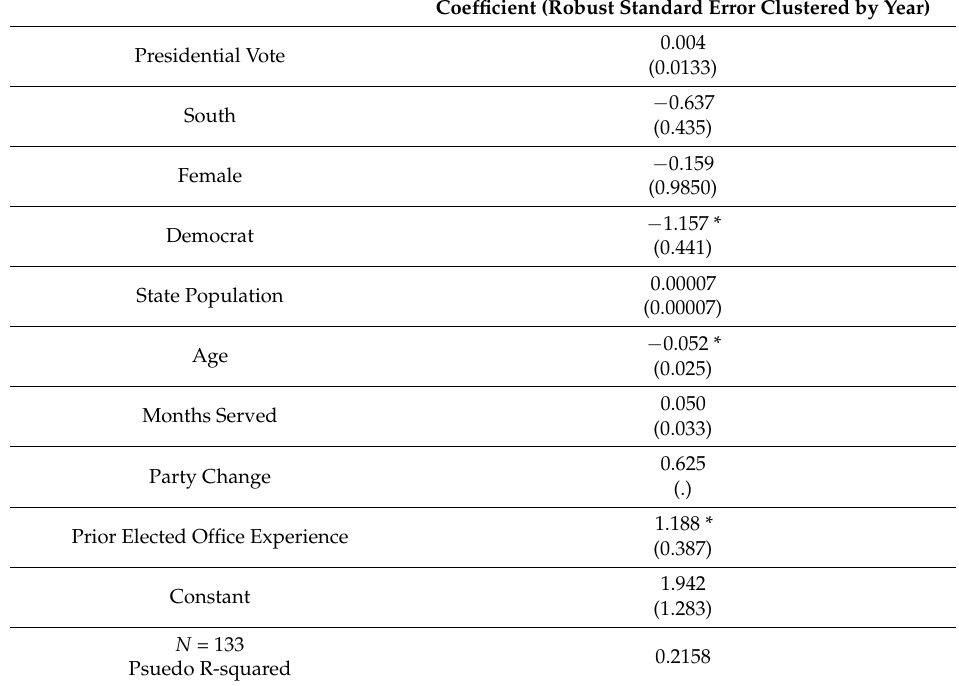
Table 2. Logit Predicting Whether or Not an Appointed Senator Runs for the